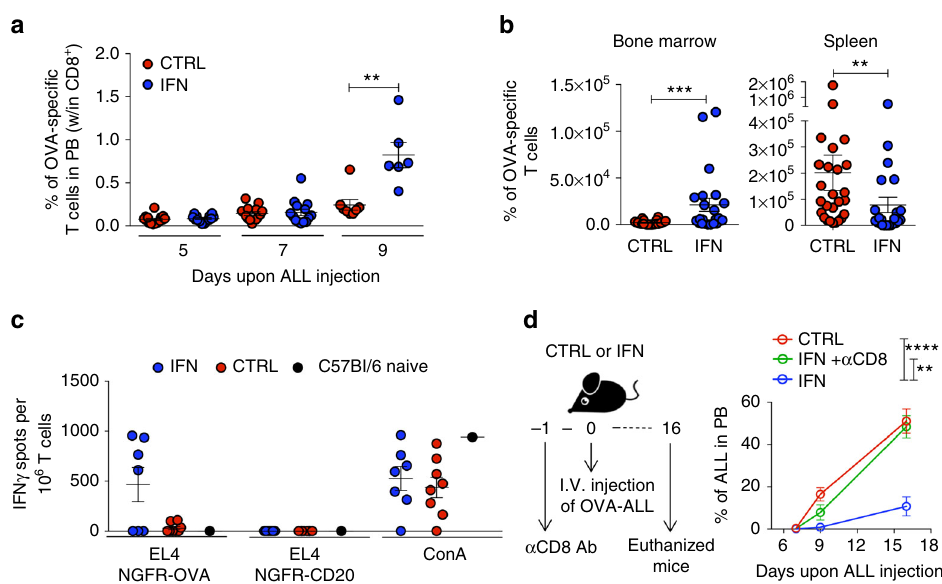
Fig. 2 IFN gene therapy activates adaptive immunity. a Percentage (mean ± SEM) of OVA-speci fi c T cells in the PB of IFN ( n = 14 – 6) and CTRL ( n = 15 – 8) mice. ** p < 0.01, Mann Whitney performed at 9 days upon OVA-ALL injection. Each dot represents a mouse (one out of fi ve experiments is shown). b Absolute numbers (mean±SEM) of OVA-speci fi c T cells in the BM and spleen, 9 days upon tumor injection, in IFN ( n = 23) and CTRL ( n = 26) mice from 3 independent experiments. ** p < 0.01, *** p < 0.001, Mann – Whitney. Each dot represents a mouse. c Splenic CD8 + T cells from IFN ( n = 7) and CTRL ( n = 8) mice 9 days upon tumor injection or from non tumor-bearing mice tested by IFN γ -ELISPOT against the EL4 target cell line transduced with NGFR- OVA or NGFR-hCD20 bidirectional LV. Concanavalin A (ConA) stimulation is used as positive control. Each dot represents a mouse. d Experimental design and percentage (mean±SEM) of OVA-ALL in the PB of IFN ( n = 9), CD8-depleted IFN ( n = 7) and CTRL ( n = 9) mice. ** p < 0.01, **** p <